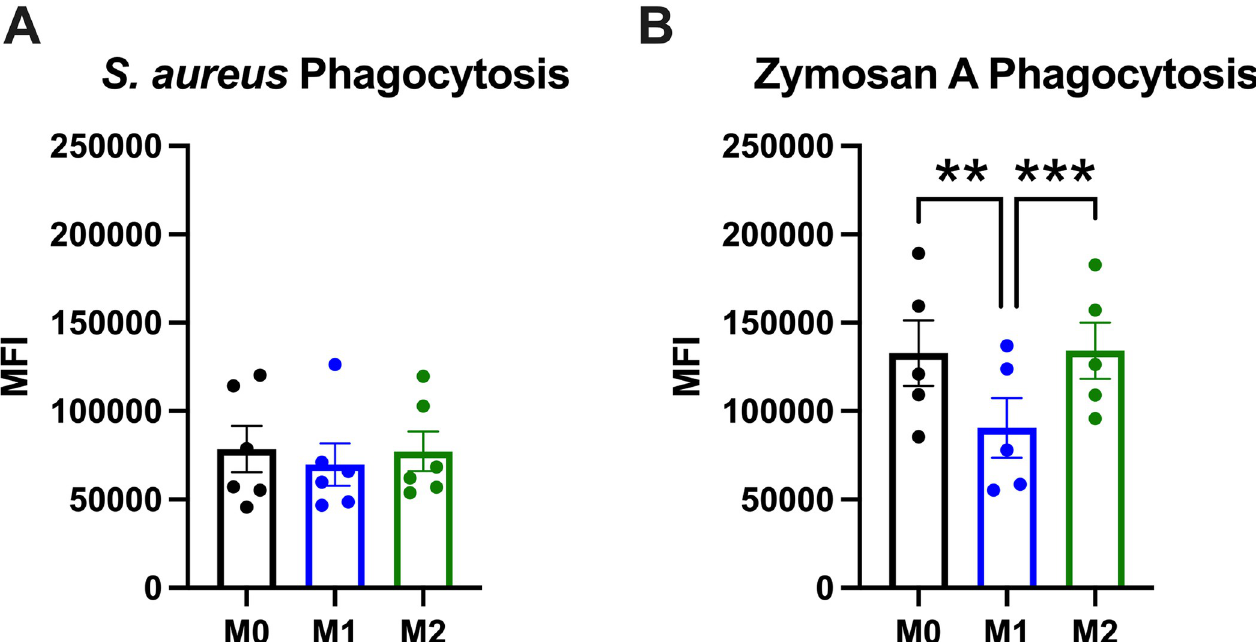
Fig 6. Polarized hMDMs are phagocytic, and M1 hMDMs are significantly less phagocytic of Zymosan A pHrodo Red BioParticles than M0 or M2 hMDMs. hMDMs were assayed for phagocytosis of (A) S. aureus and (B) Zymosan A pHrodo Red BioParticles over two hours. n = 6 biological replicates (3 males, 3 females) for Fig 5A and n = 5 biological replicates (2 males, 3 females) for Fig 5B, with 3 technical replicates per biological replicate and polarization state. Data are presented as mean ± SEM. �� p < 0.01, ��� p < 0.001 by repeated measures one-way ANOVA with Tukey’s test for multiple